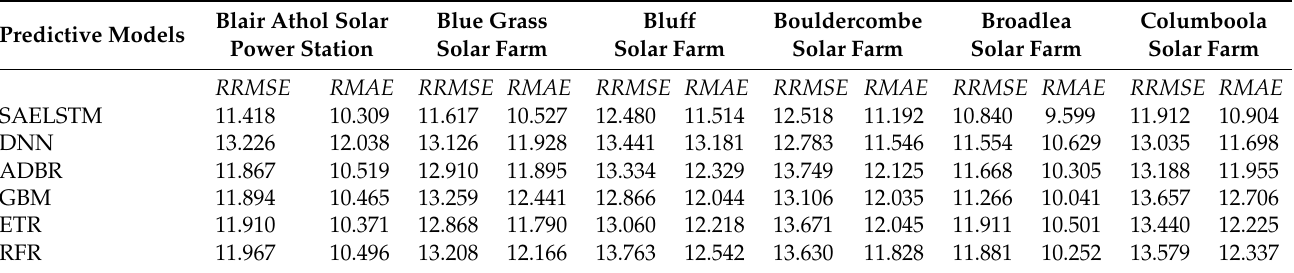
Table 7. As per Table 5 but measured in terms of the relative root mean square error ( RRMSE , %) and relative mean absolute error ( RMAE , %) in the testing